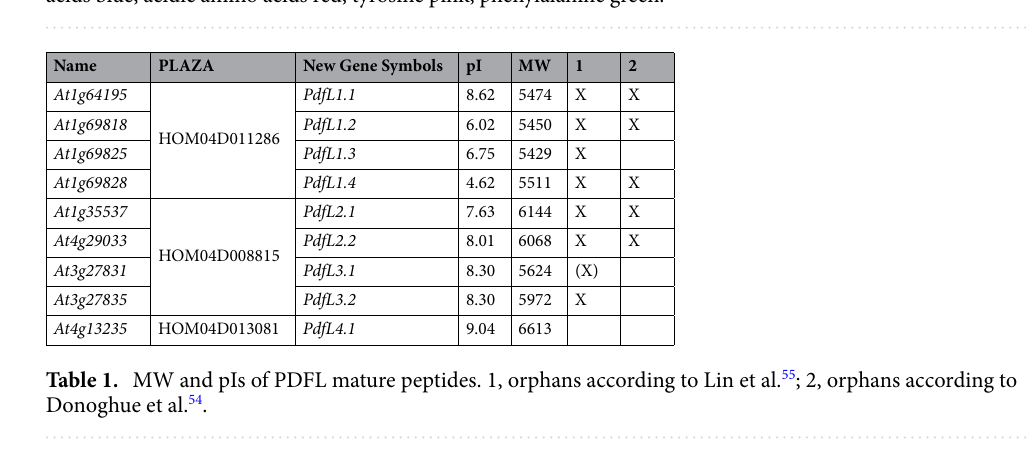
Figure 2. Sequence logo of PDFL precursor proteins. Signal peptide boxed in grey. Cysteine yellow, basic amino acids blue, acidic amino acids red, tyrosine pink, phenylalanine green.